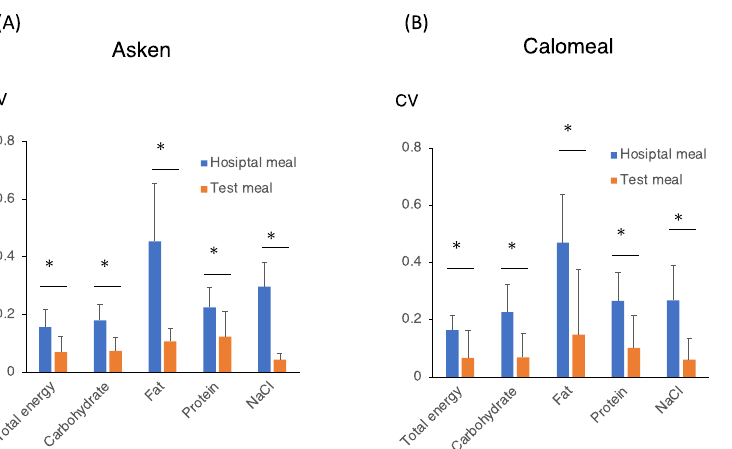
Figure 3. CV for total energy and each nutrient of the hospital meal and the test meal for 5 days. Data were measured by the Asken ( A ) and Calomeal ( B ) apps. The y-axis indicates the CV of the measured to theoretical value ratio. Data are represented as the mean ± SD (n = 18). * p < 0.05.